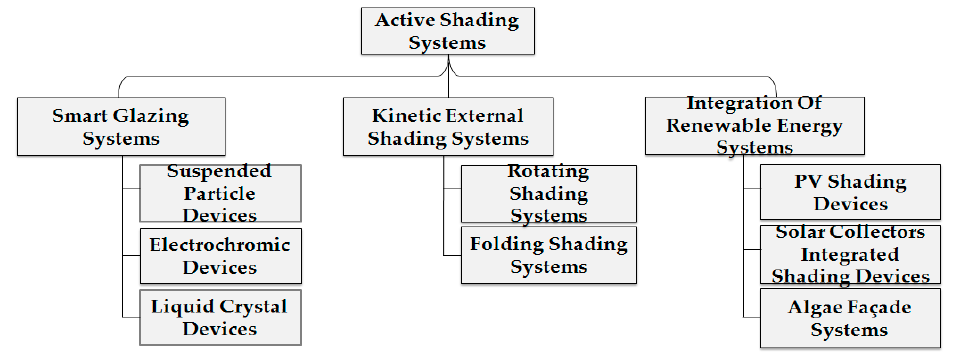
Figure 1. Active shading systems classification diagram